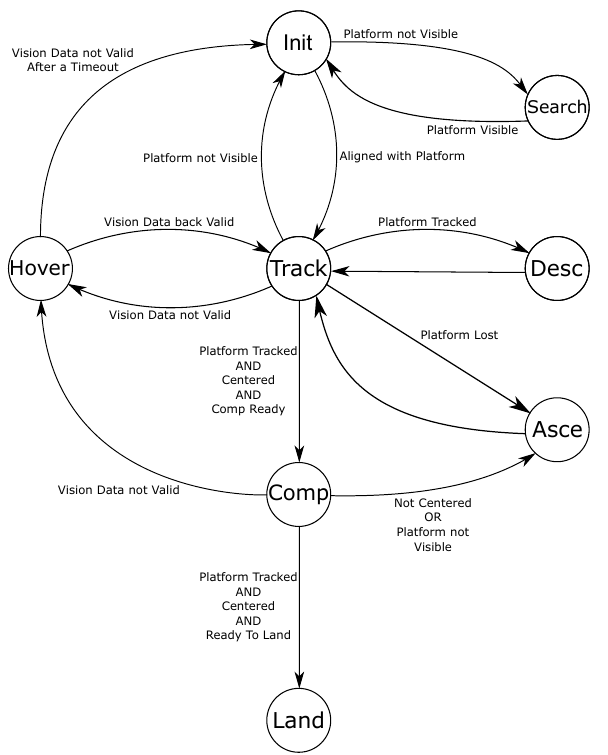
Figure 4. The diagram of the proposed finite state machine for the autonomous